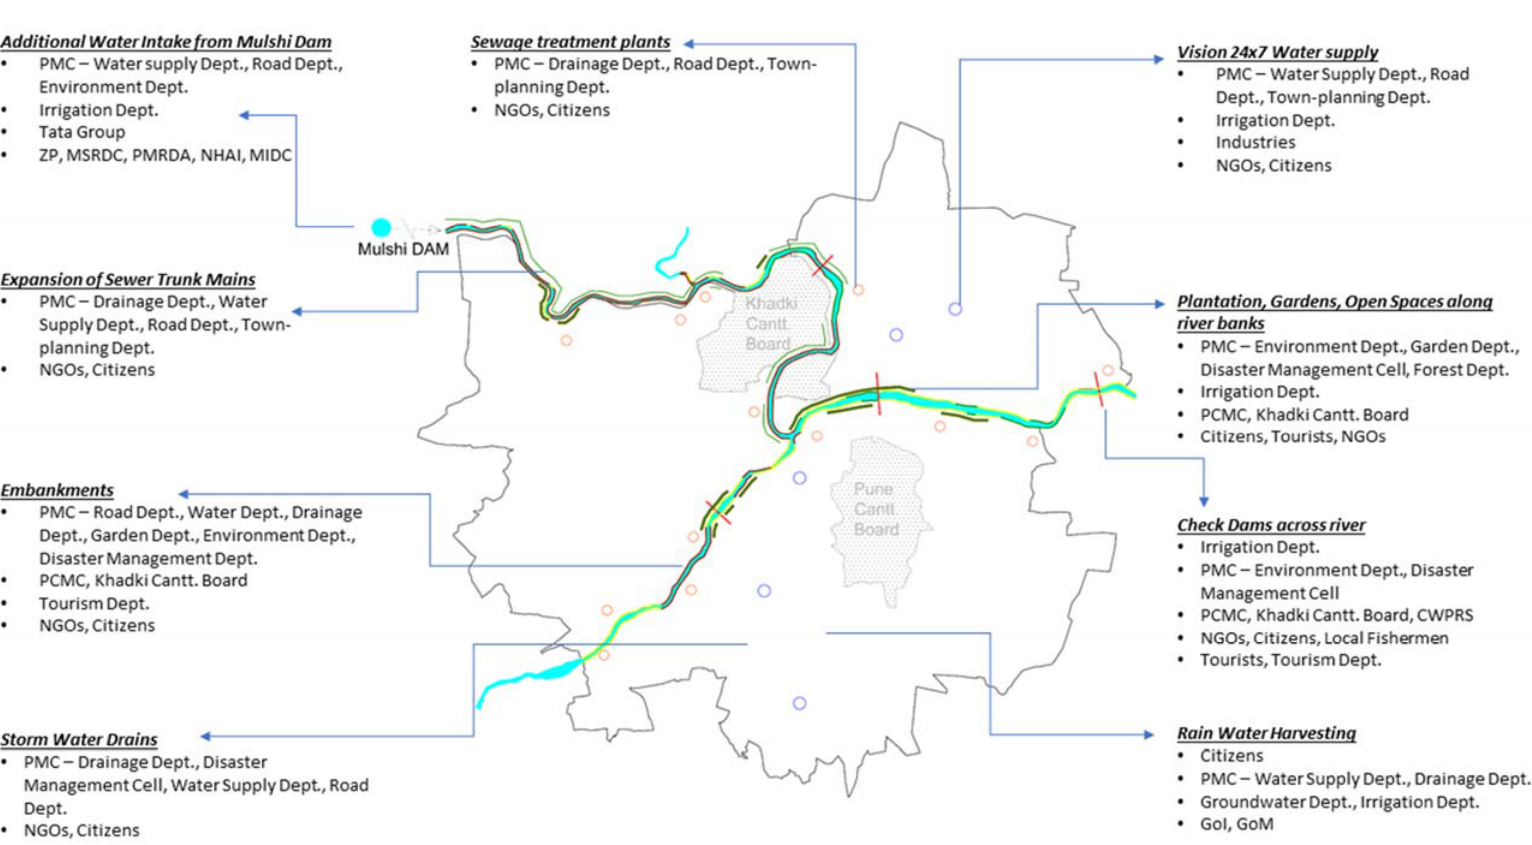
Figure 4. Stakeholders involved in adaptation responses.